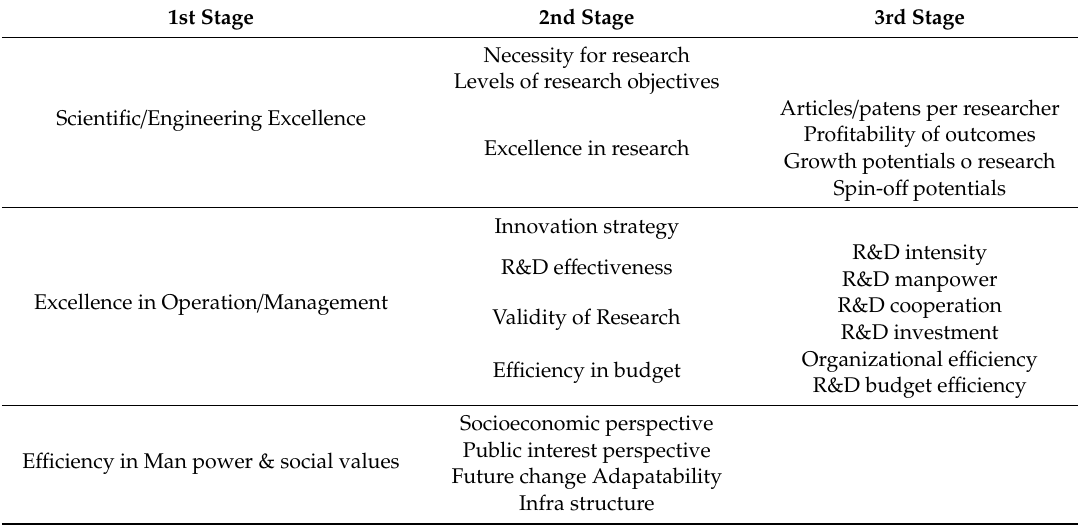
Table 2. AHP weighting